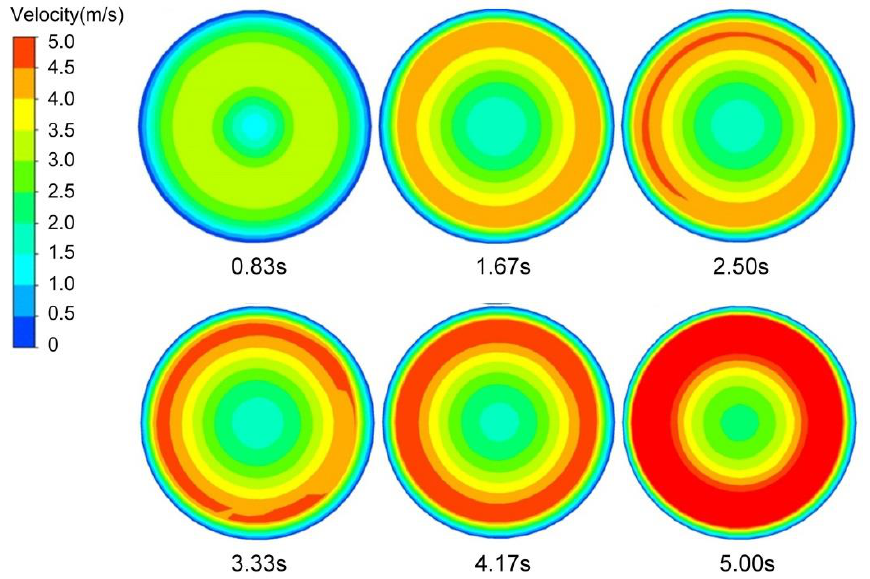
Figure 16. Variation of the flow field with time during the acceleration stage under the high-level EMS for the sectional view at half-height.